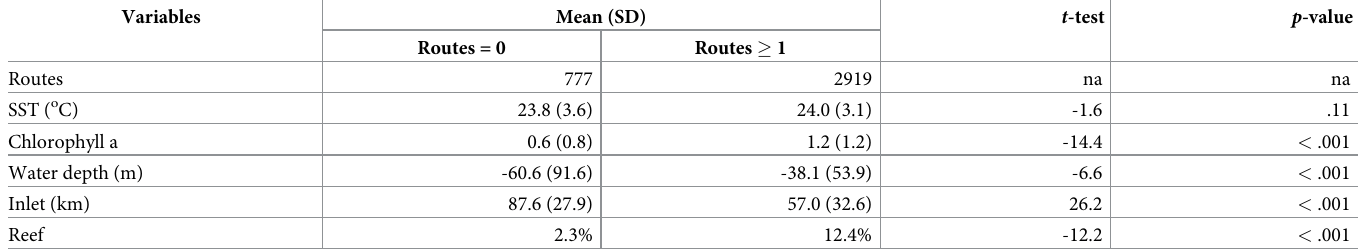
Table 1. Descriptive statistics of grid cells associated with the presence and absence of recreational boating routes. Recreational boating routes (Routes), sea surface temperature (SST), chlorophyll a concentrations, water depth, distance of the centroid of each grid cell to the nearest inlet (Inlet), and abundance of artificial reefs (Reef). Variables